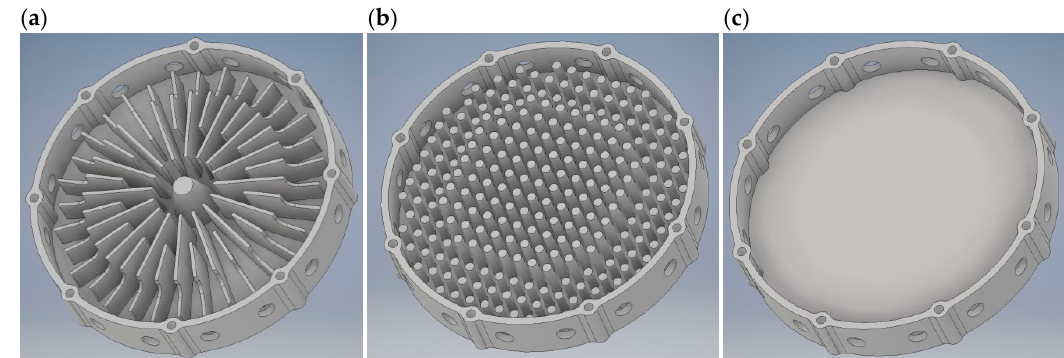
Figure 1. Investigated types of the actuator’s enclosure design: ( a ) case 1 with classic fins; ( b ) case 2 with pin fins on a rectangular grid; ( c ) case 3 without fins. Table 1. Specification of the loudspeakers.